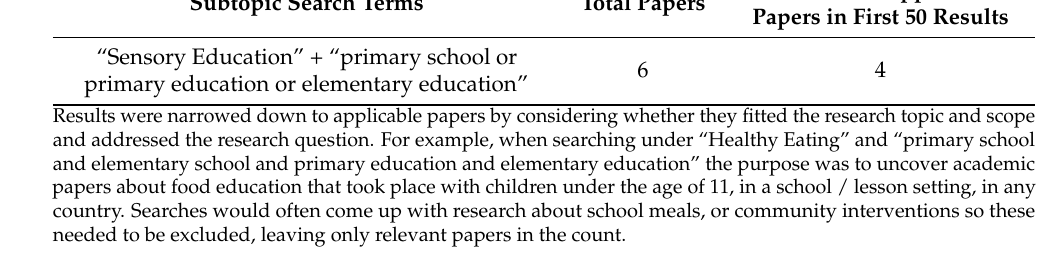
Table A2. Example of the food literacy framework scoring spreadsheet. Source: Authors. The frame- work is structured under Themes (1-3), which are divided into subgroups in grey. Each subgroup is made up of individual competencies. The total score for each subgroup was used to create graphs for analysis. Red competencies were added to the framework by the authors. In England, Relation- ships and Sex Education and Healthy Eating (RSE&HE), Design and Technology (D&T) and Science curriculums included food education. The red text indicates competencies added by the authors. Food Literacy Framework Country: England Food Literacy Competencies